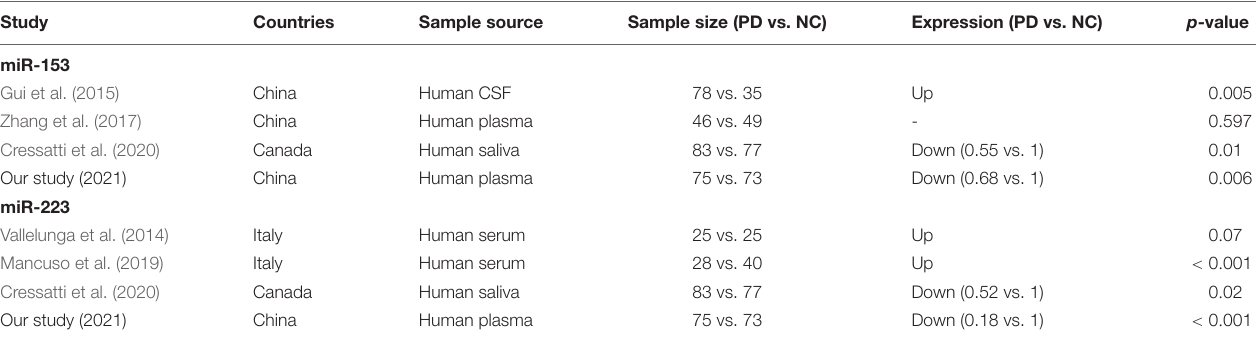
TABLE 2 | Serial studies on miR-153 and miR-223 expression levels in PD vs.